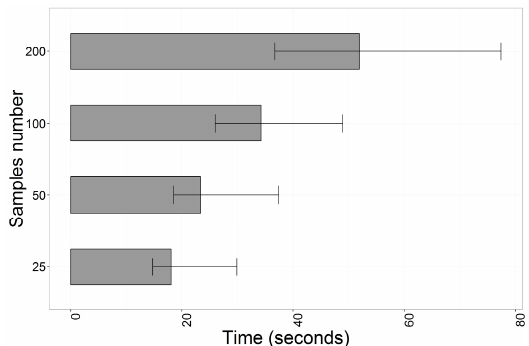
Figure 8. Processing time measured for different sample size sets. The PCG was equal configured in all cases, executing GA for 10 times to average its processing time. For testing purposes, GA population size was set at 30 individuals and 10